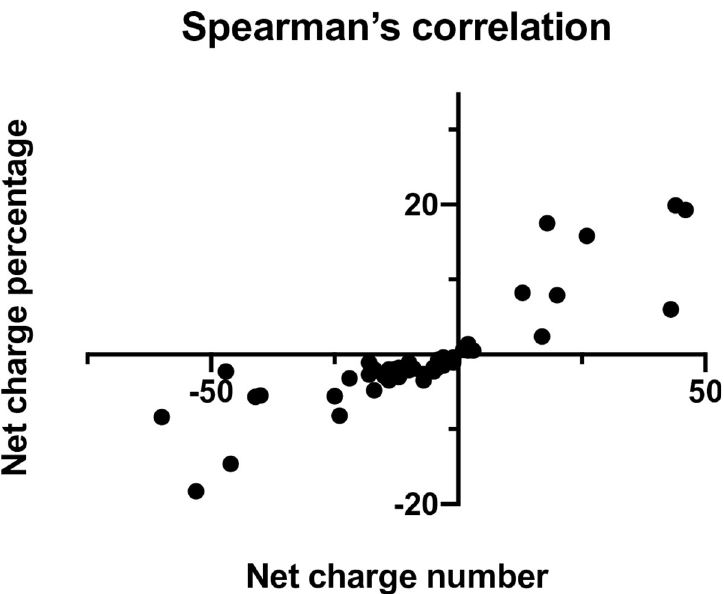
Fig 2. Spearman’s correlation analysis plot. The net charge percentage was plotted against the net charge number for MPPs in this figure demonstrating a strong correlation (r = 0.923; p < 0.0001).